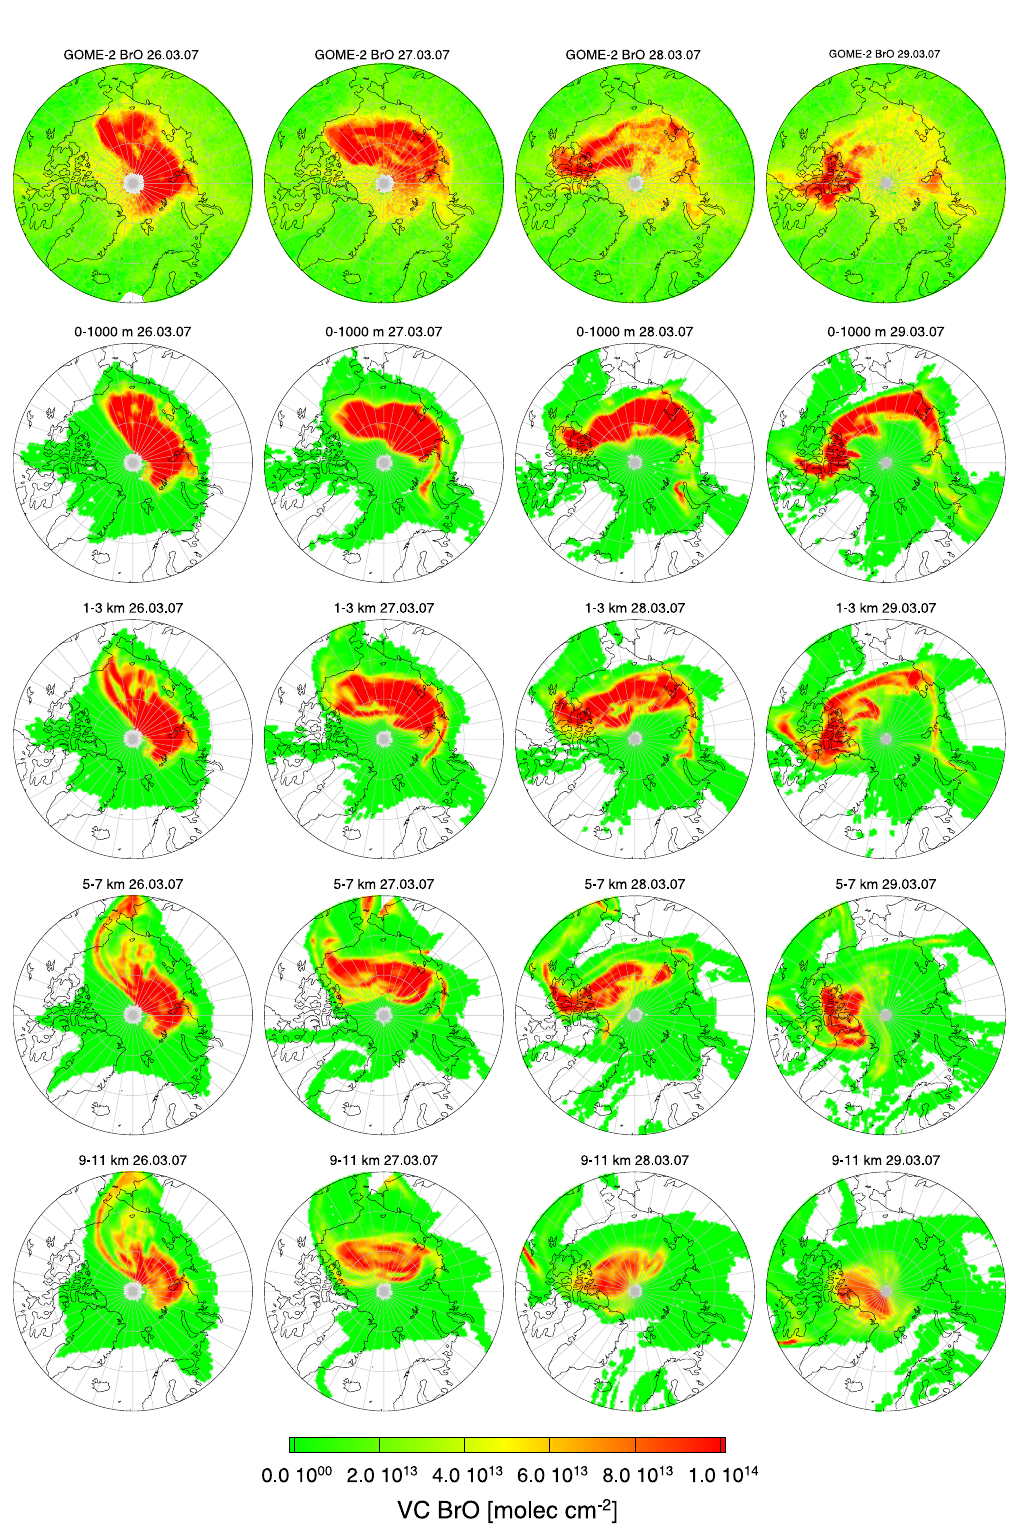
Fig. 4. Daily averaged FLEXPART model results adjusted to GOME-2 measurement data (26–29 March 2007). On top stratospheric corrected GOME-2 measurement data using boundary layer AMF (400m) are